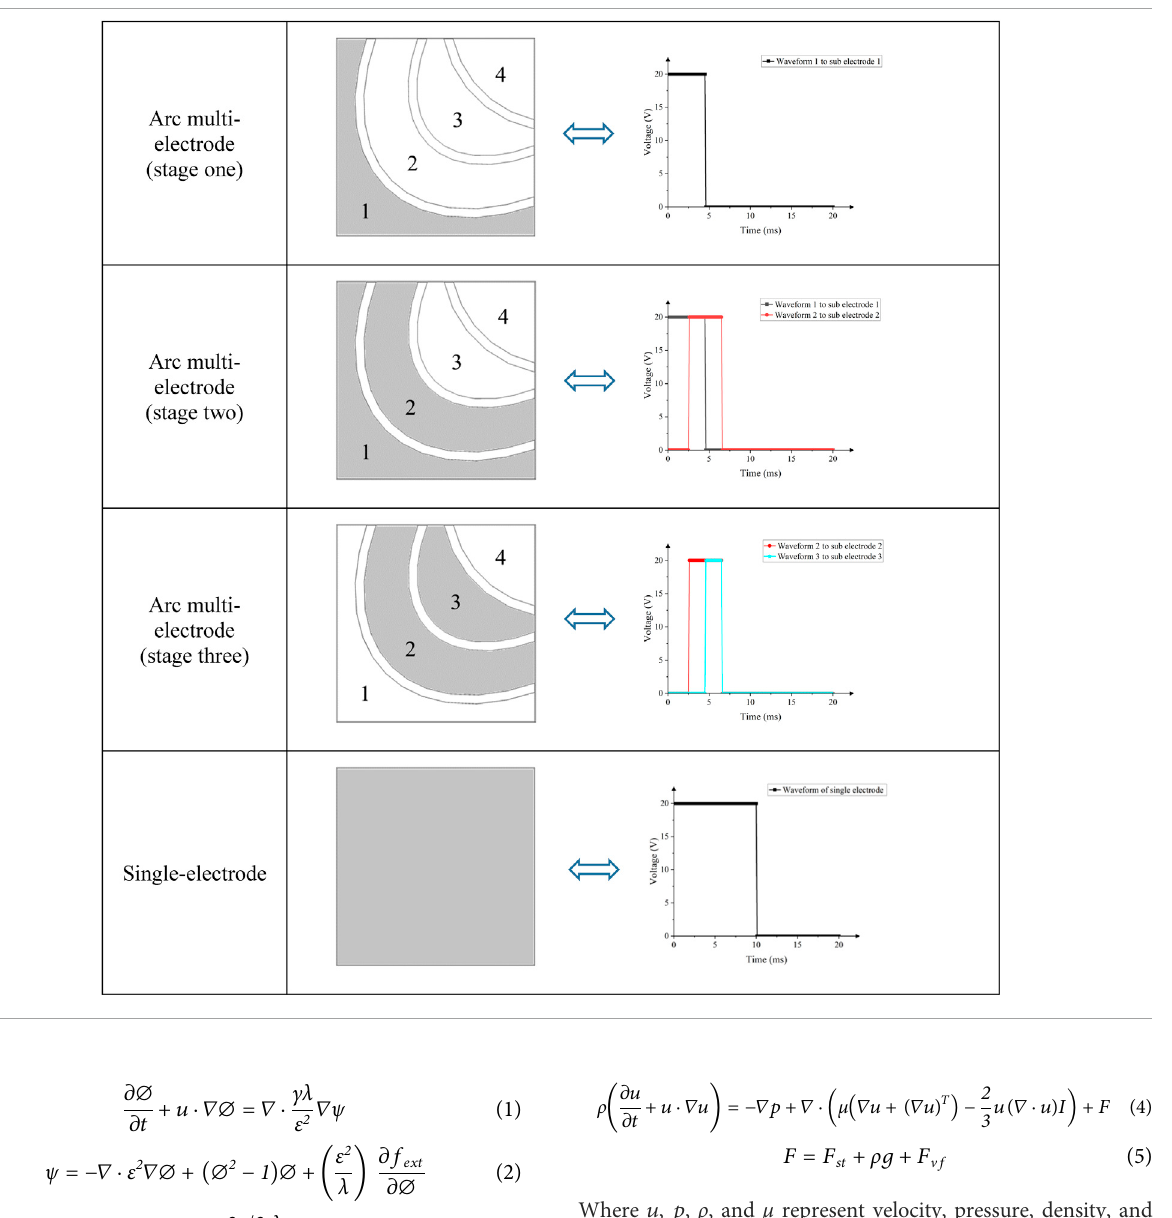
TABLE 2 Driving waveforms and driving mode used for two electrode